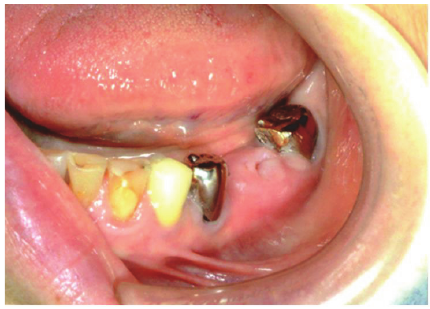
Figure 3: Panoramic radiographic image taken in the first examina- tion. Radiopaque area in the alveolar crest of lower left teeth 6 and 7, showing osteosclerosis and formation of bone resembling cortical bone.